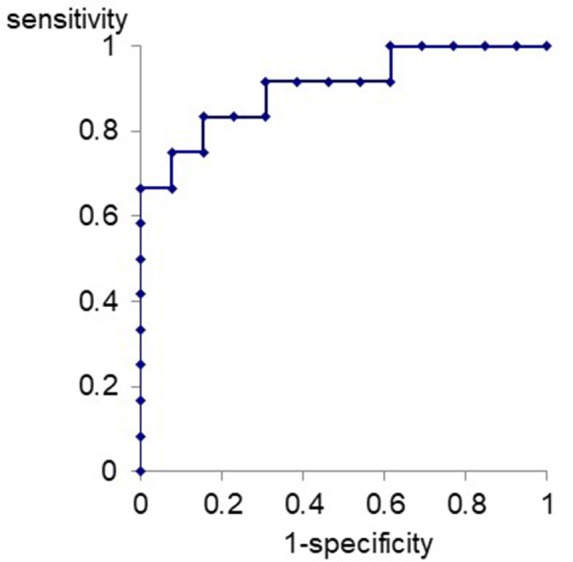
ROC curve for differentiation of VM patients from MD patients.